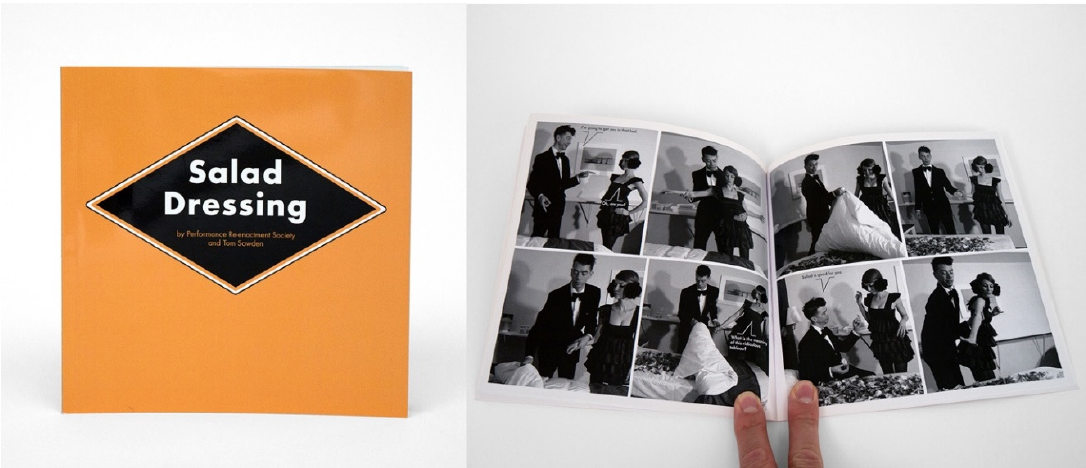
Figure 34. The Performance Re-enactment Society and Tom Sowden, Salad Dressing , 2011.